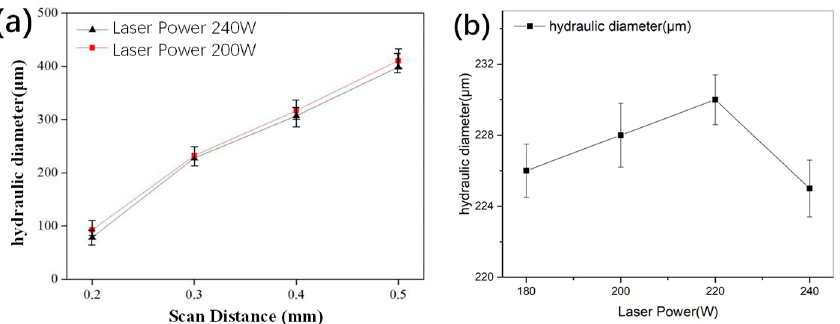
Figure 7. Comparison of the hydraulic diameter of the grid structures. ( a ) Hydraulic diameters of the grid structures formed by different scan spacings. ( b ) Hydraulic diameters of the grid structures formed using different laser powers.